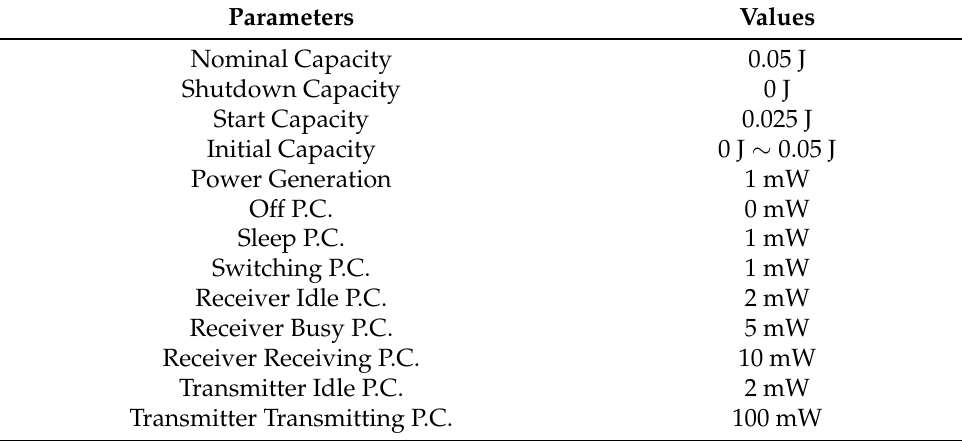
Table 2. Energy consumption parameters. (P.C. stands for power